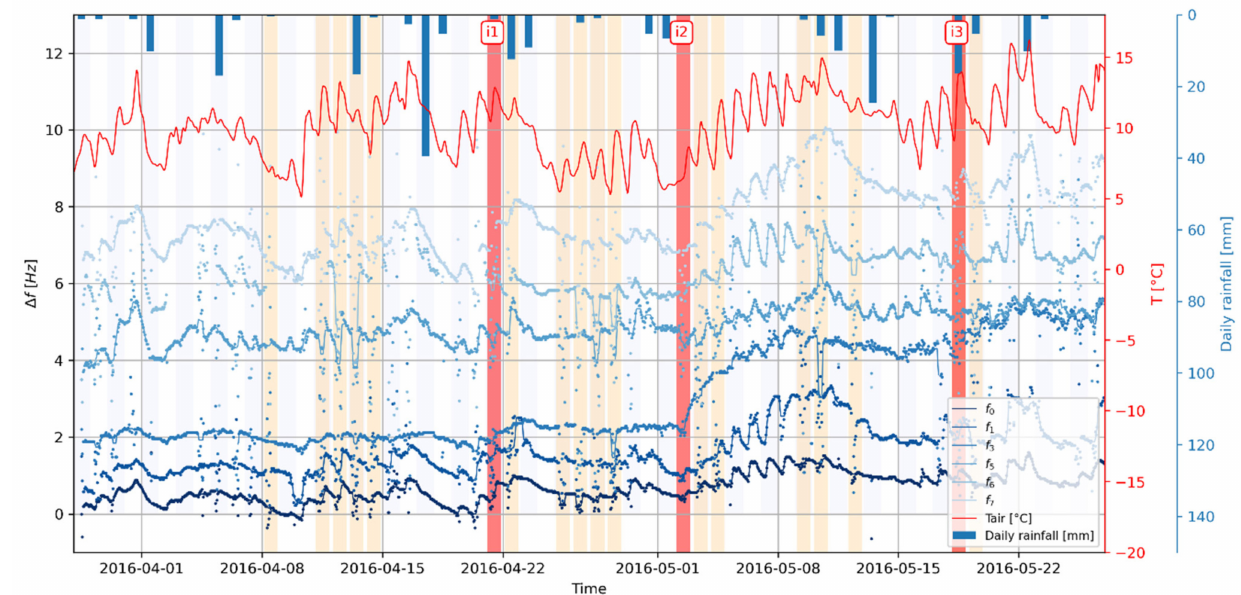
Figure 3. Natural frequencies f 0 , f 1 , f 3 , f 5 , f 6 , and f 7 change with time (frequencies have been arbitrarily shifted for the sake of easier comparison). Continuous lines show the rolling median computed on 12 h long windows. Air temperature on-site is shown as red curve, and daily rainfall is shown as blue bars (downwards axis). Reinforcement work stages are shown in the background: drilling days (light orange) and grout injection (i 1 , i 2 , i 3 in